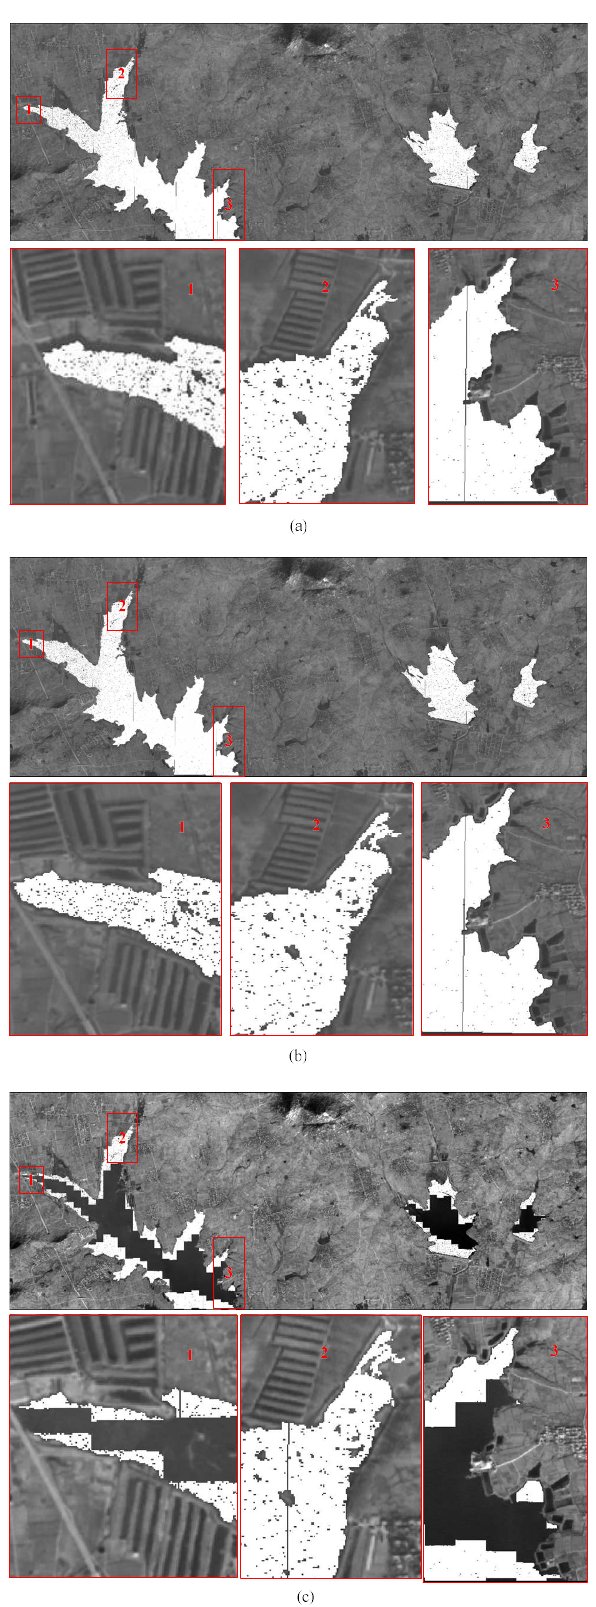
Figure 11. The image pair block 1 ROI matching results. ( a ) Block matching. ( b ) Sub-block matching. ( c ) End-block matching.